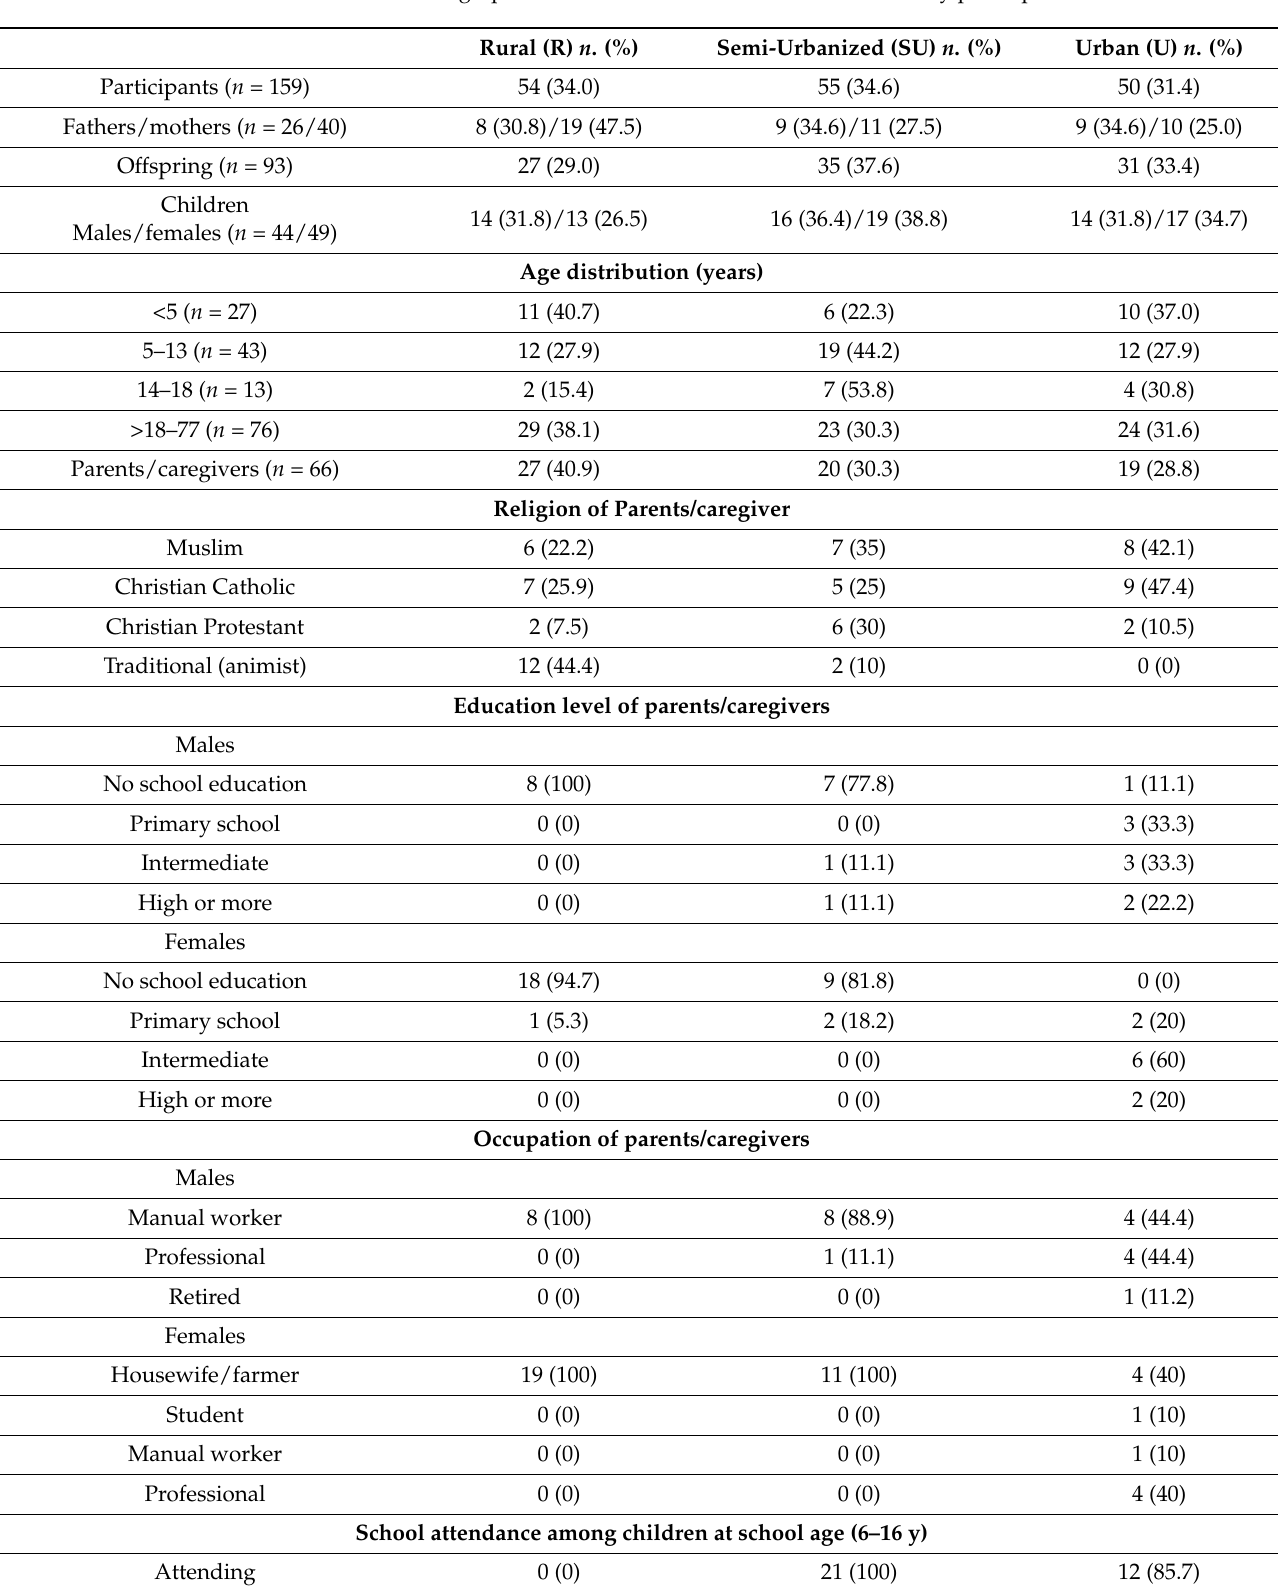
Table 1. Demographic and socio-cultural characteristics of study